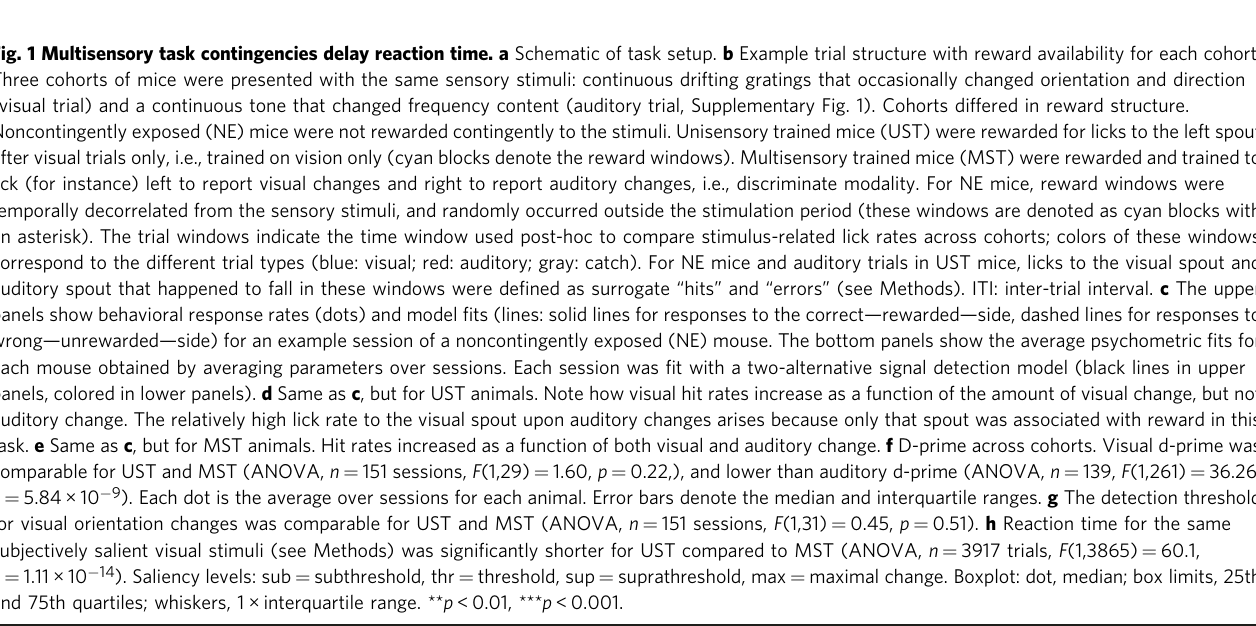
Fig. 1 Multisensory task contingencies delay reaction time. a Schematic of task setup. b Example trial structure with reward availability for each cohort. Three cohorts of mice were presented with the same sensory stimuli: continuous drifting gratings that occasionally changed orientation and direction (visual trial) and a continuous tone that changed frequency content (auditory trial, Supplementary Fig. 1). Cohorts differed in reward structure. Noncontingently exposed (NE) mice were not rewarded contingently to the stimuli. Unisensory trained mice (UST) were rewarded for licks to the left spout after visual trials only, i.e., trained on vision only (cyan blocks denote the reward windows). Multisensory trained mice (MST) were rewarded and trained to lick (for instance) left to report visual changes and right to report auditory changes, i.e., discriminate modality. For NE mice, reward windows were temporally decorrelated from the sensory stimuli, and randomly occurred outside the stimulation period (these windows are denoted as cyan blocks with an asterisk). The trial windows indicate the time window used post-hoc to compare stimulus-related lick rates across cohorts; colors of these windows correspond to the different trial types (blue: visual; red: auditory; gray: catch). For NE mice and auditory trials in UST mice, licks to the visual spout and auditory spout that happened to fall in these windows were de fi ned as surrogate “ hits ” and “ errors ” (see Methods). ITI: inter-trial interval. c The upper panels show behavioral response rates (dots) and model fi ts (lines: solid lines for responses to the correct — rewarded — side, dashed lines for responses to wrong — unrewarded — side) for an example session of a noncontingently exposed (NE) mouse. The bottom panels show the average psychometric fi ts for each mouse obtained by averaging parameters over sessions. Each session was fi t with a two-alternative signal detection model (black lines in upper panels, colored in lower panels). d Same as c , but for UST animals. Note how visual hit rates increase as a function of the amount of visual change, but not auditory change. The relatively high lick rate to the visual spout upon auditory changes arises because only that spout was associated with reward in this task. e Same as c , but for MST animals. Hit rates increased as a function of both visual and auditory change. f D-prime across cohorts. Visual d-prime was comparable for UST and MST (ANOVA, n = 151 sessions, F (1,29) = 1.60, p = 0.22,), and lower than auditory d-prime (ANOVA, n = 139, F (1,261) = 36.26, p = 5.84 × 10 − 9 ). Each dot is the average over sessions for each animal. Error bars denote the median and interquartile ranges. g The detection threshold for visual orientation changes was comparable for UST and MST (ANOVA, n = 151 sessions, F (1,31) = 0.45, p = 0.51). h Reaction time for the same subjectively salient visual stimuli (see Methods) was signi fi cantly shorter for UST compared to MST (ANOVA, n = 3917 trials, F (1,3865) = 60.1, p = 1.11 × 10 − 14 ). Saliency levels: sub = subthreshold, thr = threshold, sup = suprathreshold, max = maximal change. Boxplot: dot, median; box limits, 25th and 75th quartiles; whiskers, 1 × interquartile range. ** p < 0.01, *** p <